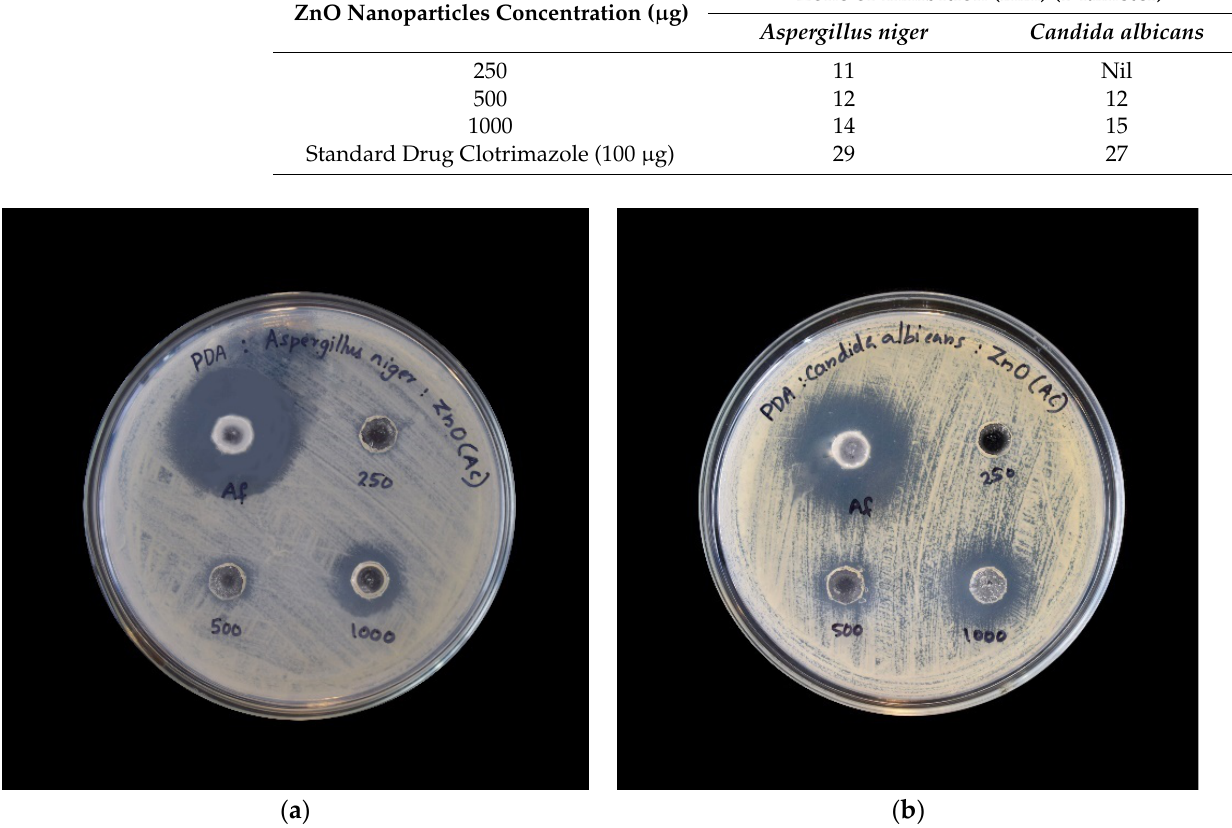
Figure 11. Antifungal activity of ZnO nanoparticles against ( a ) Aspergillus niger and ( b ) Candida albicans.